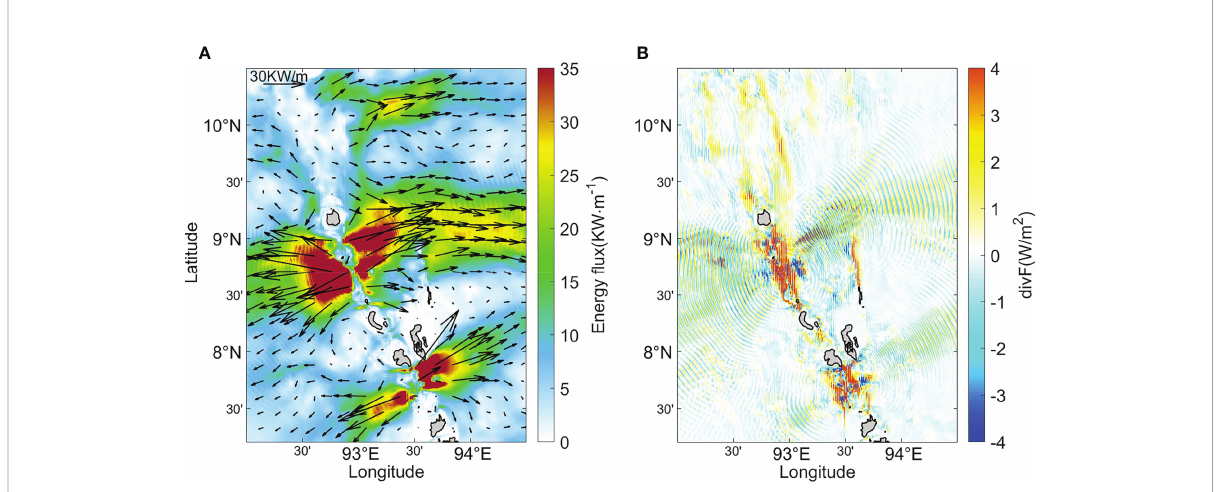
FIGURE 13 The distribution of (A) baroclinic energy fl ux and (B) the divergence during the spring tide period in the subdomain C in the Experiment